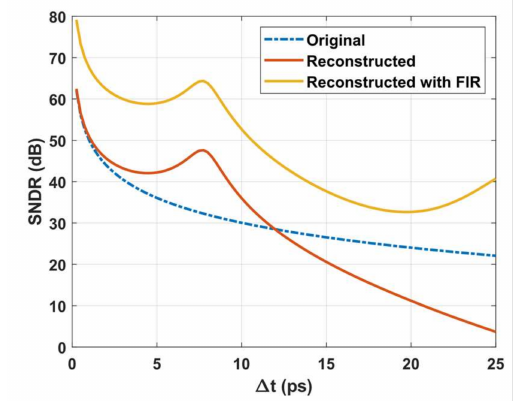
Figure 4. SNDR curves in different situations with changes in the time delay. First the signal was reconstructed and then it was transmitted to the FIR; this process further improved the